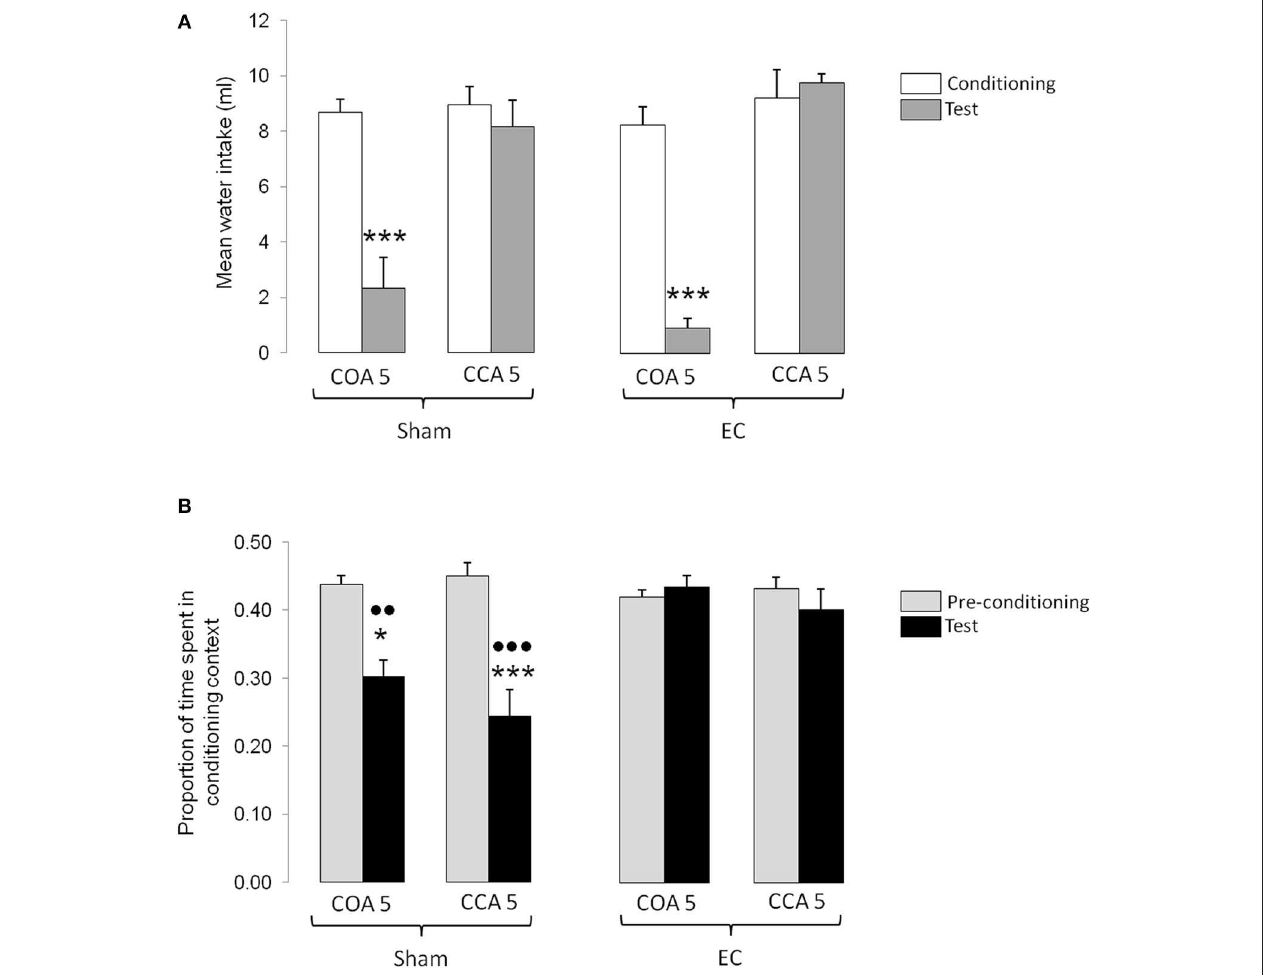
FIGURE 3 | Effect of a short ISI on COA and CCA in Sham- and EC-lesioned groups. (A) Represents the mean odorized water intakes ( ± S.E.M.) measured during the conditioning (white bars) and testing (gray bars) sessions in each experimental group. *** p < 0.001 as compared with the amount of odorized water intake during conditioning in the same group and with the amount of odorized water intake during testing in the corresponding CCA group. (B) represents the mean proportion of time ( ± S.E.M.) spent in the conditioning context for each experimental group. Bars represent the proportion of time spent in the conditioning context (mean time spent in the conditioning context/time of the session) calculated in the pre-conditioning (gray bars) and testing (black) sessions. * , *** p < 0.05 and 0.001 as compared with the proportion of time spent in the conditioning context during pre-conditioning in the same group; , p < 0.01 and 0.001 as compared with the proportion of time spent in the conditioning context during testing in the corresponding EC-lesioned-group. EC, lesion of the entorhinal cortex; Sham, sham-lesion of the entorhinal cortex; COA, conditioned odor aversion; CCA, conditioned context